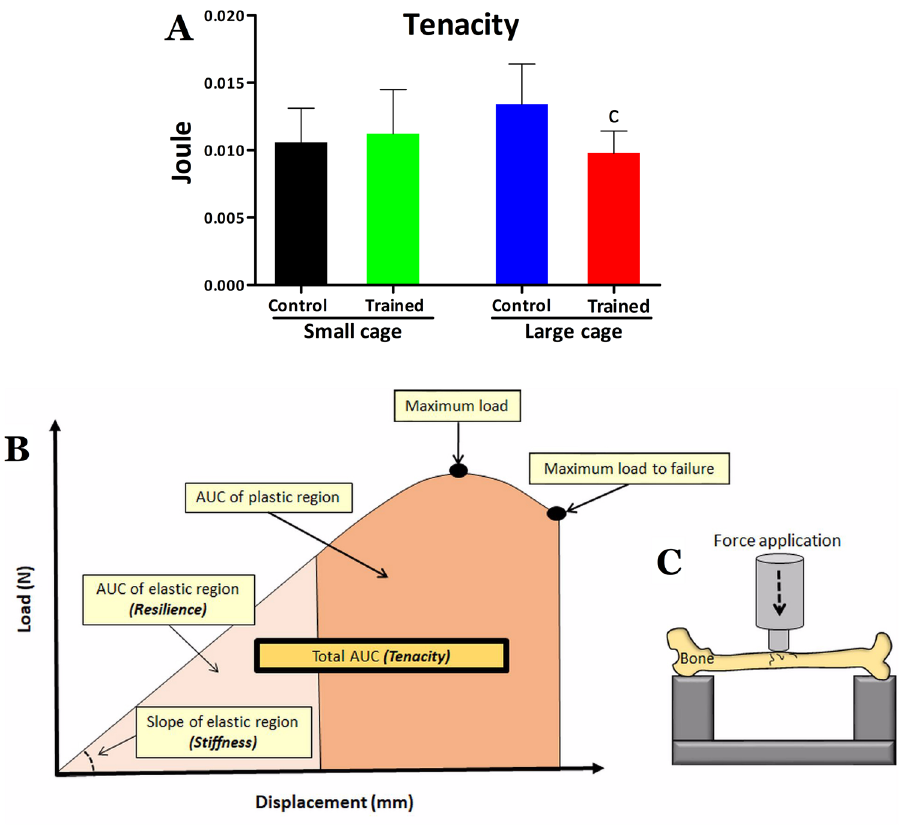
Figure 2. Femoral tenacity for the control and trained groups kept in small cage or large cage in ( A ). Tenacity is regarded as the total area under curve from a typical load vs displacement curve of bone ( B ). Additionally, ( B ) illustrates the resilience and stiffness, which are respectively the area under curve (AUC) of elastic region and slope of elastic region. ( C ) Illustrates how the bone was biomechanically tested using Instron Universal Machine. Statistical significance symbol: c different from LC-C (P < 0.05).